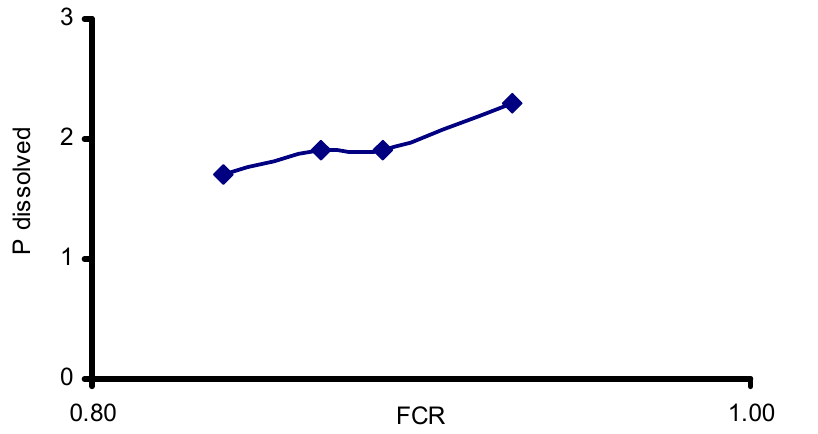
Figure 1. An example of how changes in the feed conversion ratio (FCR) due to temperature effects on the fish feeding rate and metabolism can affect the phosphorus load released by farmed rainbow trout. This change is due to an increase in FCR (such as when more feed is required to produce one kg of weight gain) that will result in a proportionally higher amount of phosphate released into the aquatic environment (data calculated from Azevedo et al. [24]).